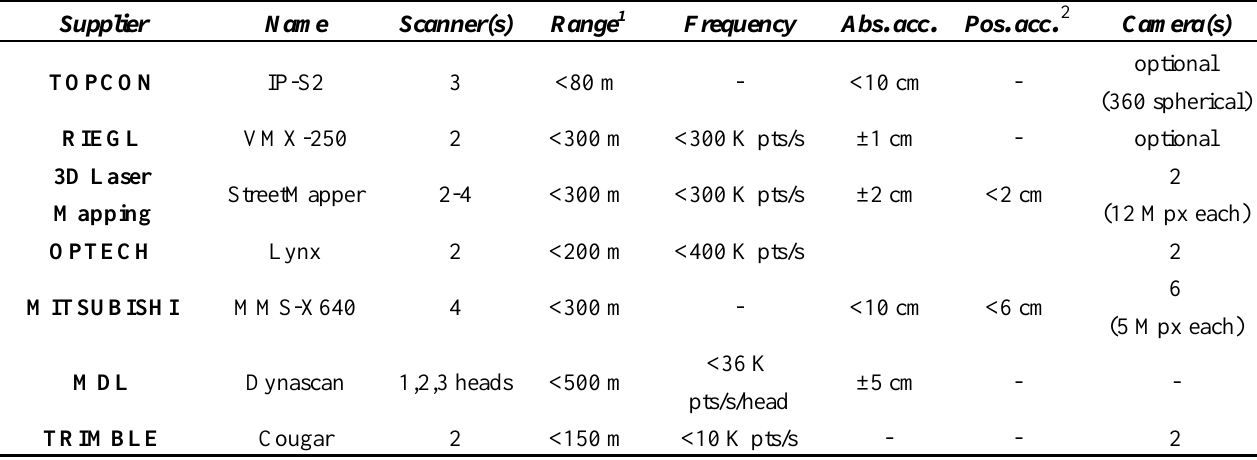
Table 8. Most common Mobile Mapping system suppliers and related components ( 1 Reflectivity of 80%; 2 Vehicle positional